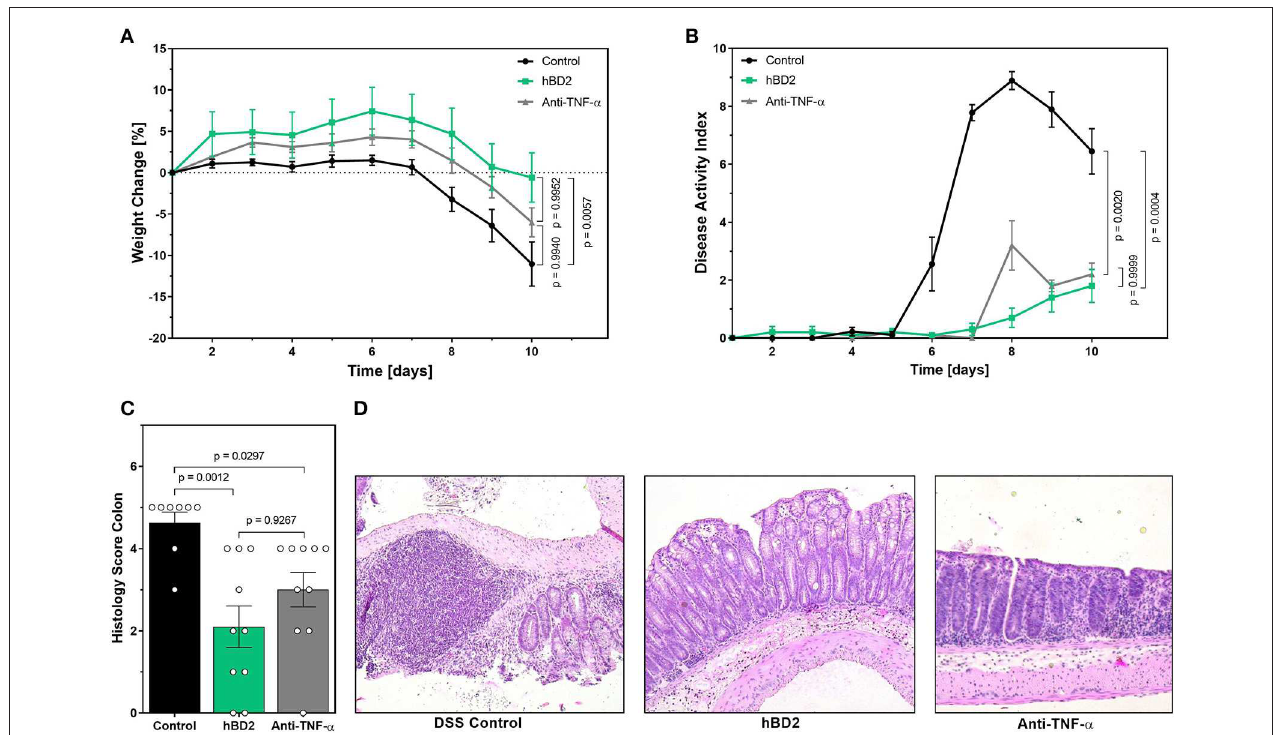
FIGURE 5 | hBD2 ameliorated the outcome of DSS colitis in vivo . Colitis was induced by adding 2% DSS into the drinking water. On day 8 DSS was removed from the drinking water. Mice were treated either once a day s.c. with 0.1 mg/kg hBD2 or intraperitoneally with an anti-TNF α antibody (300 µ g/mouse) on day 1, 4, and 8. (A) Weight change of mice during the experiment, (B) development of DAI, (C) histology score from the colon of the mice at the end of the experiment, and (D) representative images from the colon of differentially treated mice. Results are presented as mean ± SEM, control group n = 9 and treated groups n = 10. Appropriate statistical comparison are shown within the graph by a Kruskal-Wallis-test for non-parametric data with a Dunn’s